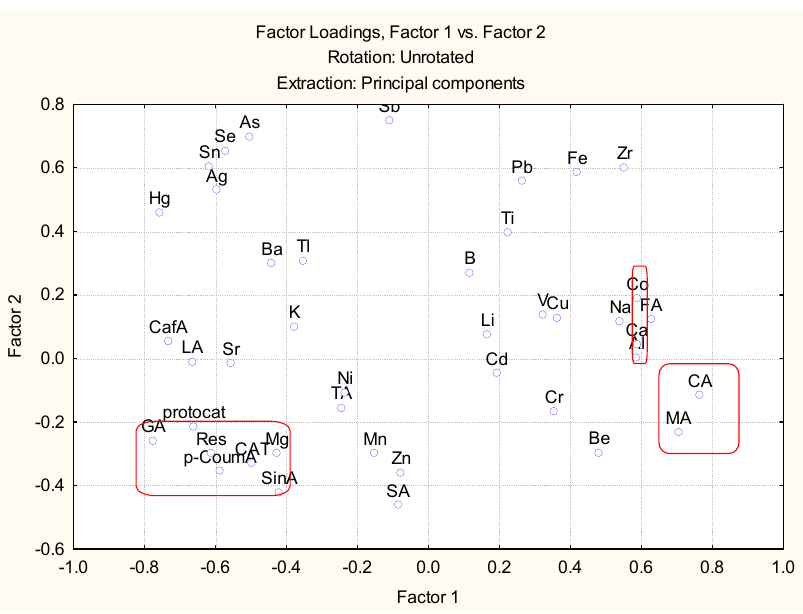
Figure 3. Biplot of factor loadings for factor 1 vs. factor 2.